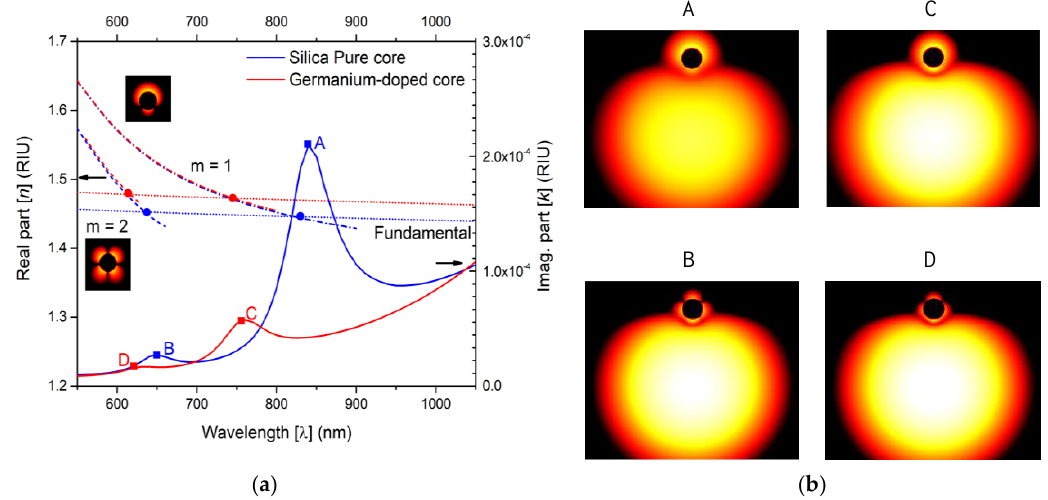
Figure 2. ( a ) RI real and imaginary part of the two D-type fiber sensors as function of wavelength for an external refractive index of 1.36. The blue solid line corresponds to the D-type pure silica core fiber, and the red solid line corresponds to the D-type with a core silica doped with 16% germanium fiber. The crossing between the dispersion curves of the metal nanowires’ modes and the fundamental modes of the fibers are indicated by the circular dots and match the frequencies of the peaks (supermodes A–D), indicated by the squared dots. ( b ) Detailed distribution of the light intensity in the cores and in the wires for the referred supermodes.